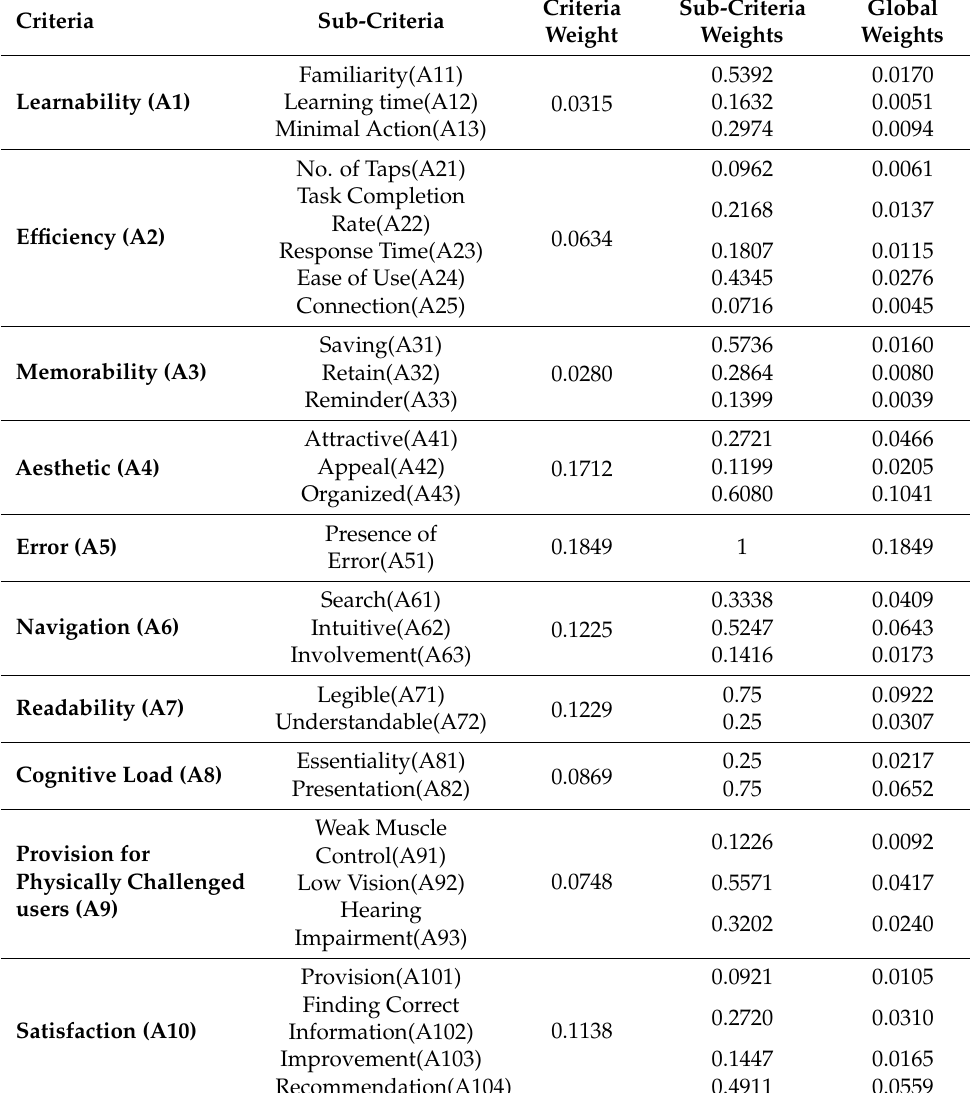
Table 16. Weights of criteria, sub-criteria and global